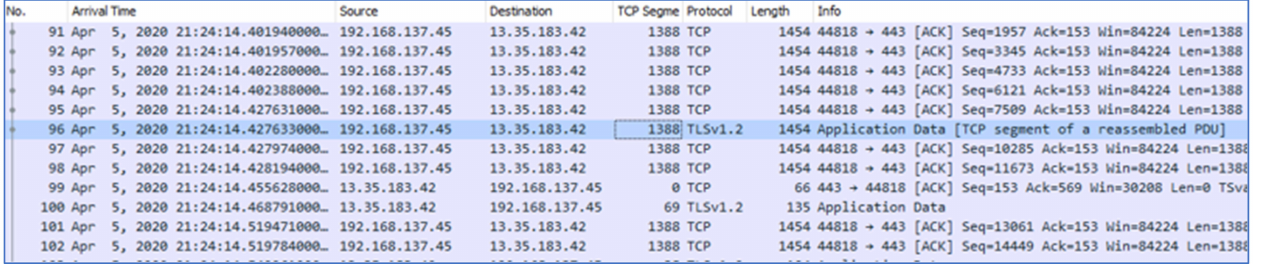
Figure 23. Media message patterns are